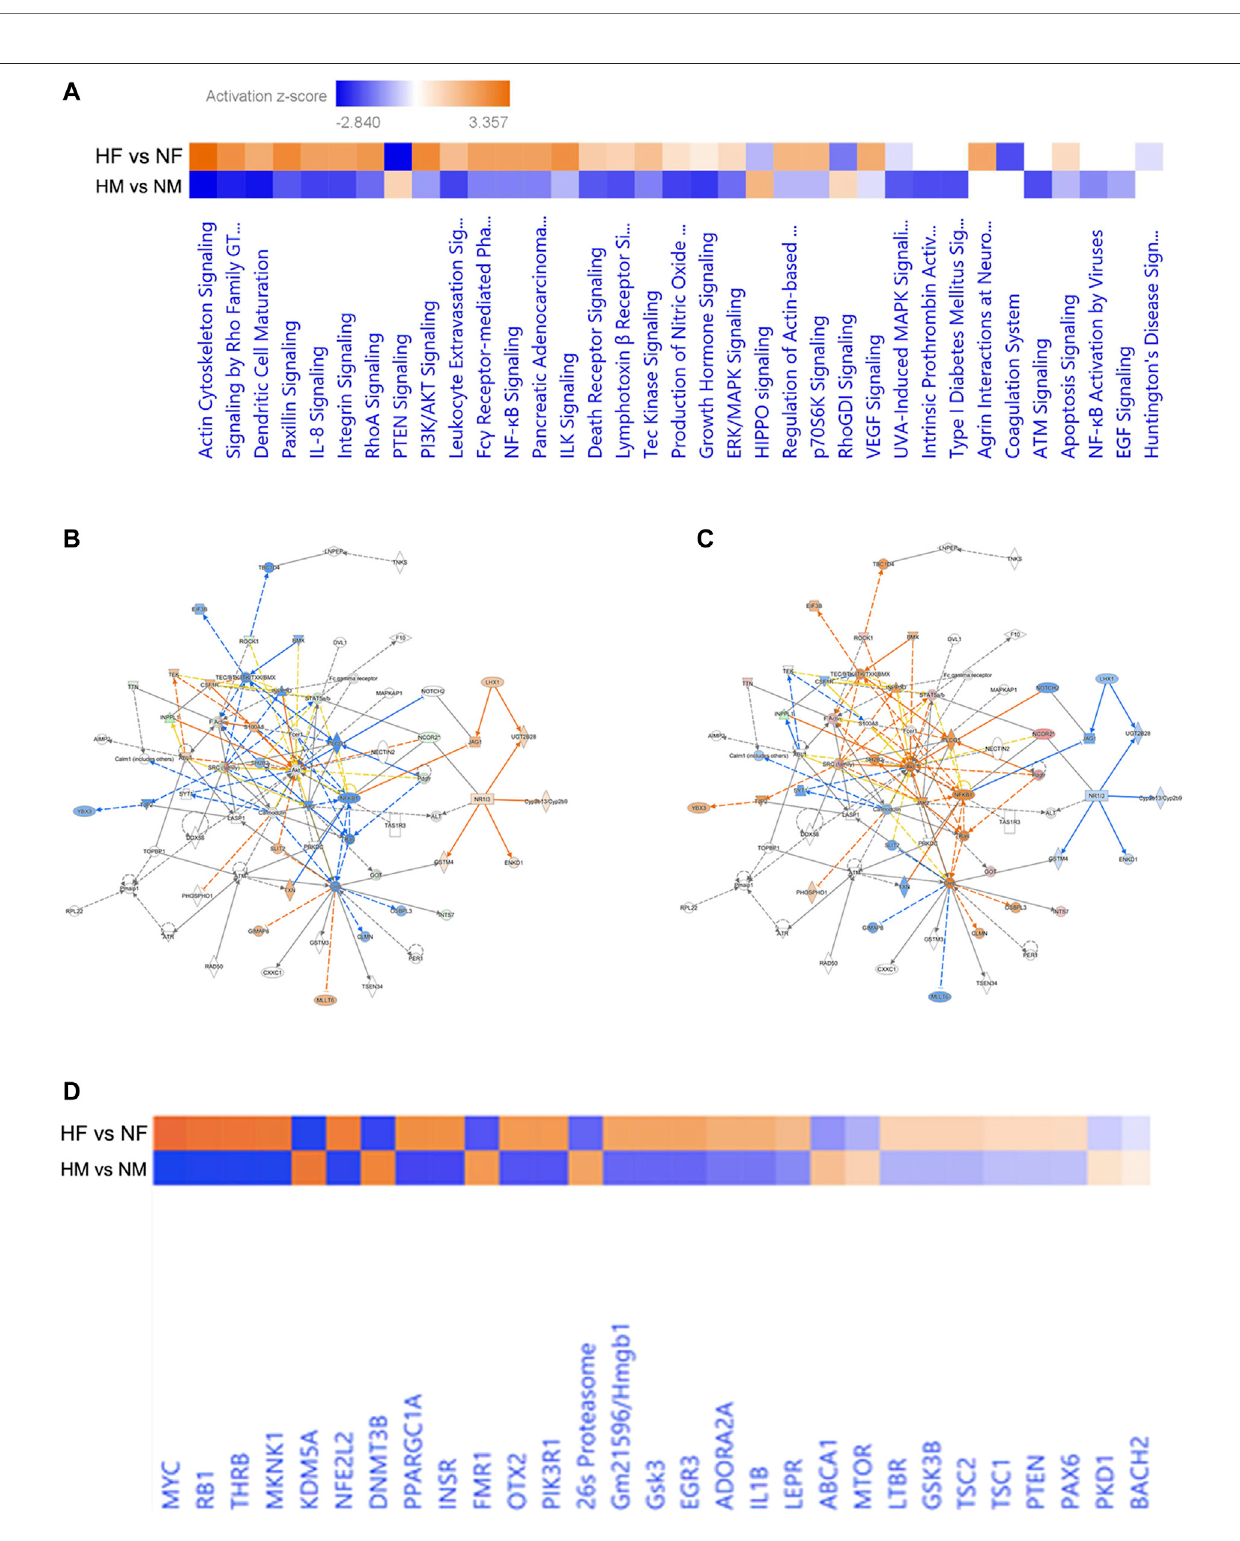
FIGURE 3 | Pathway based on the top networks. Comparative heatmap for canonical pathways of male and female brain proteome induced by hypoxia (A) , Predictive pathway for zebra fi sh male (B) and female (C) brain proteome induced by hypoxia, comparative heatmap for upstream regulators (D) .